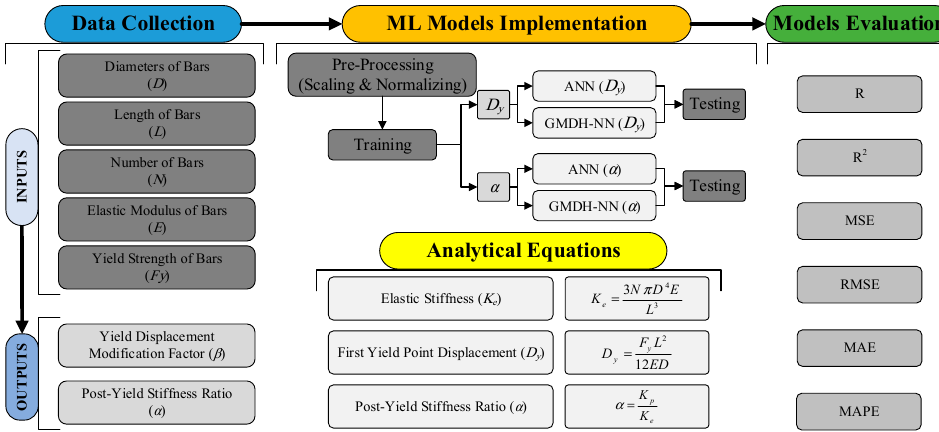
Figure 3. Overall research flowchart.